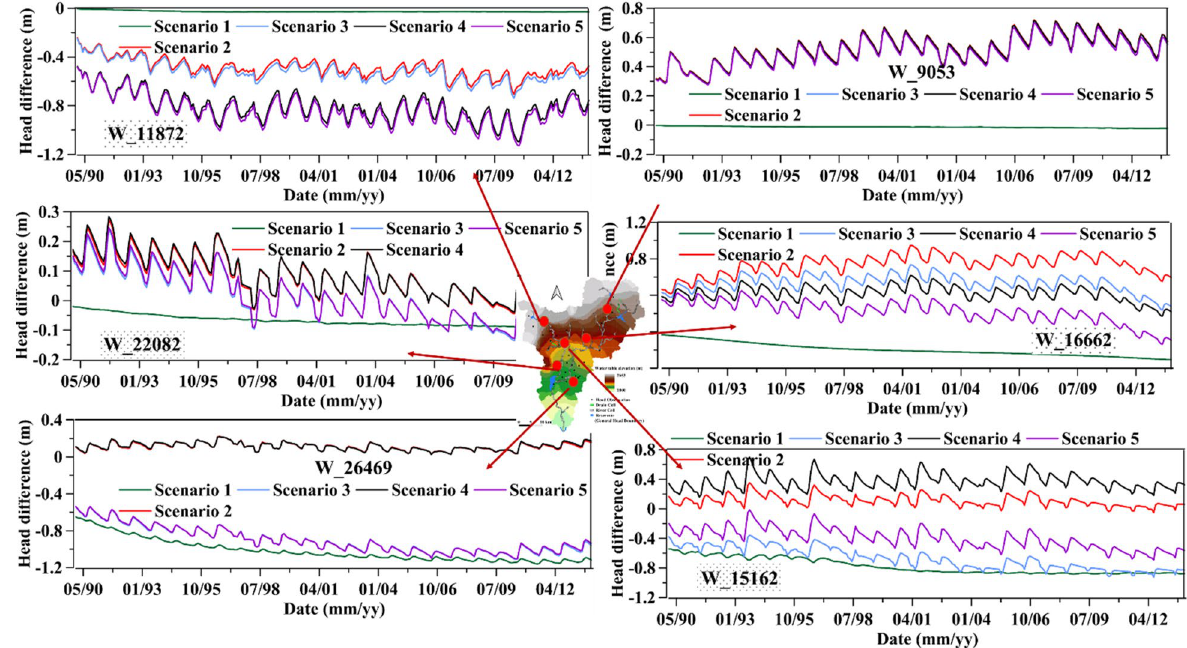
Figure 10. Groundwater level difference from the baseline scenario from 1990 to 2013: positive values show that the groundwater level decreased compared to the baseline